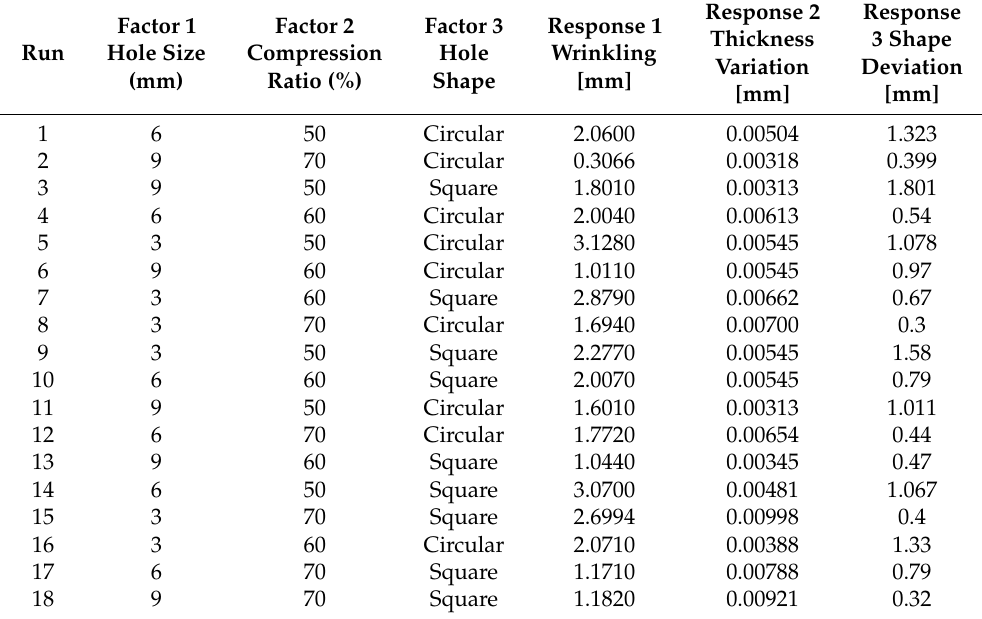
Figure 4. The measured and the simulated results of the forming force. Table 2. Design of experiment results of the wrinkling, thickness variation, and shape peak devia- tion.